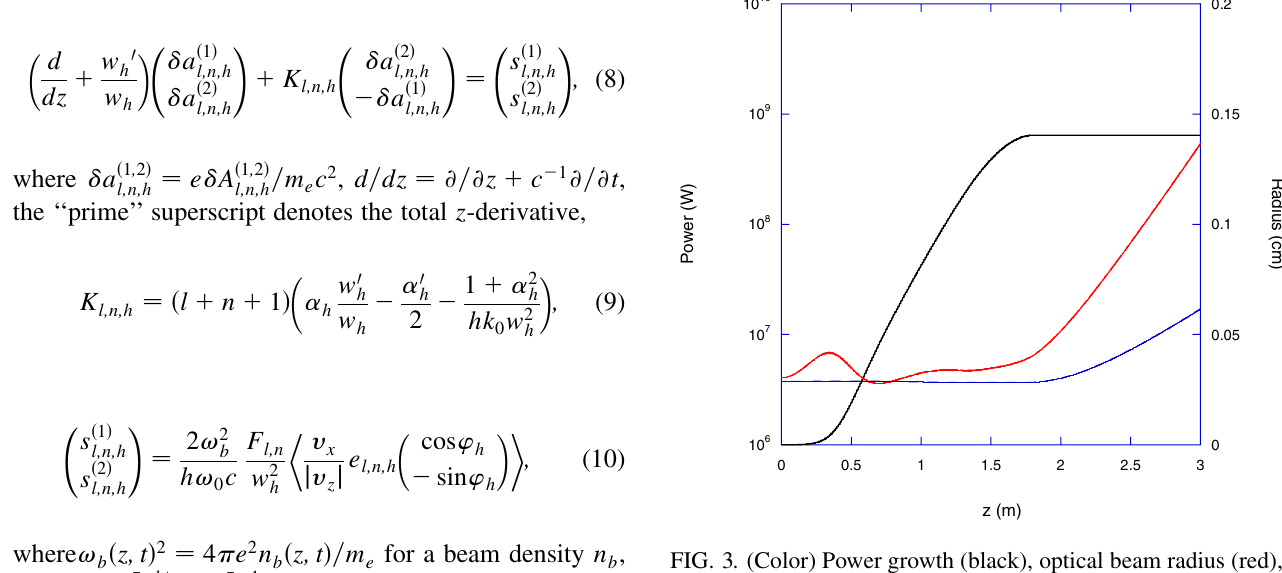
FIG. 3. (Color) Power growth (black), optical beam radius (red), and electron beam radius (blue) inside a matched-beam FEL with a uniform